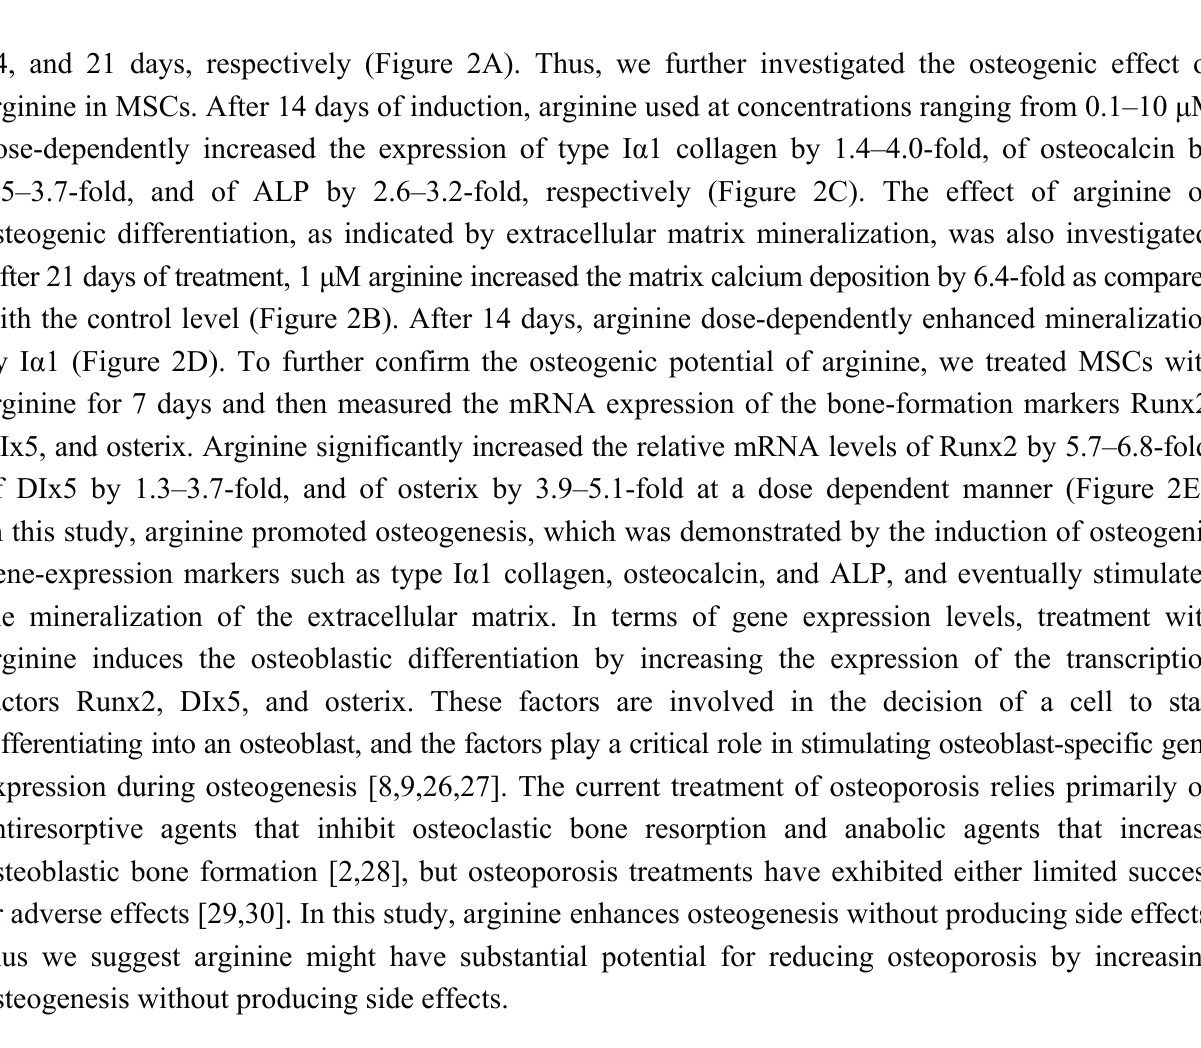
Figure 1. Effect of arginine on the proliferation of mesenchymal stem cells (MSCs).